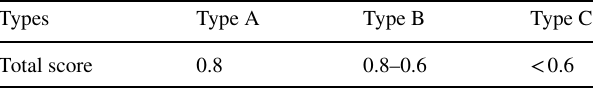
Table 6 The classification standard of reservoir types of Oligocene sandstone reservoirs in the Lengdong area